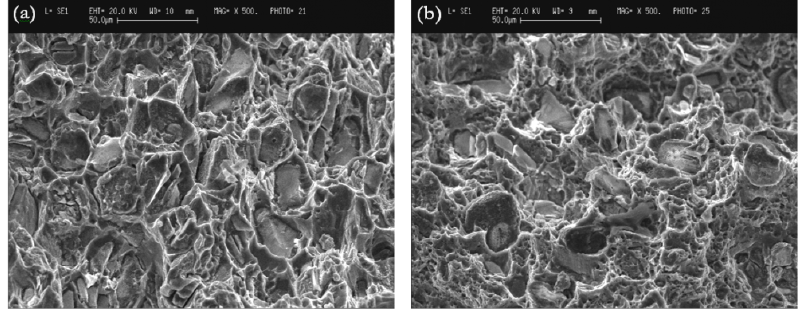
Figura 14: Micrografie SEM delle superfici di frattura dei provini di resilienza